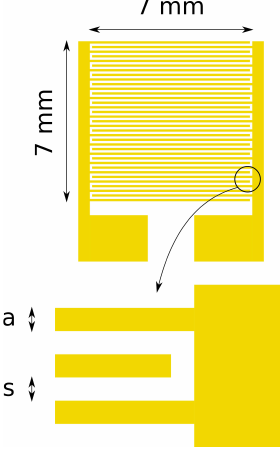
Figure 1. Schematics of the interdigital electrodes. Four electrodes with different finger widths (a) and separations (s) were deposited on a single substrate.